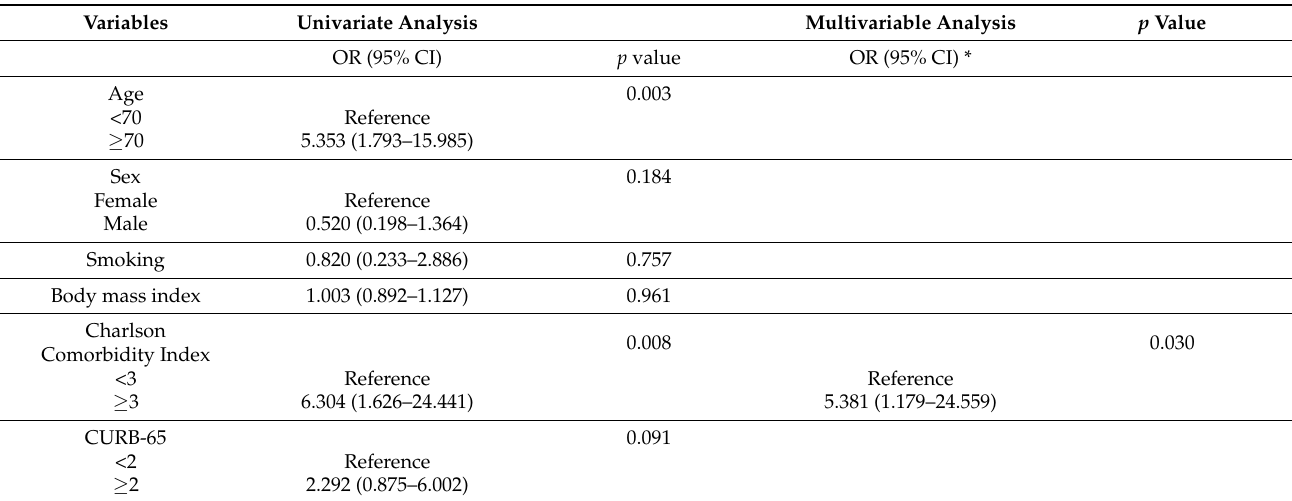
Table 2. Univariate and multivariate analyses of predictive factors for